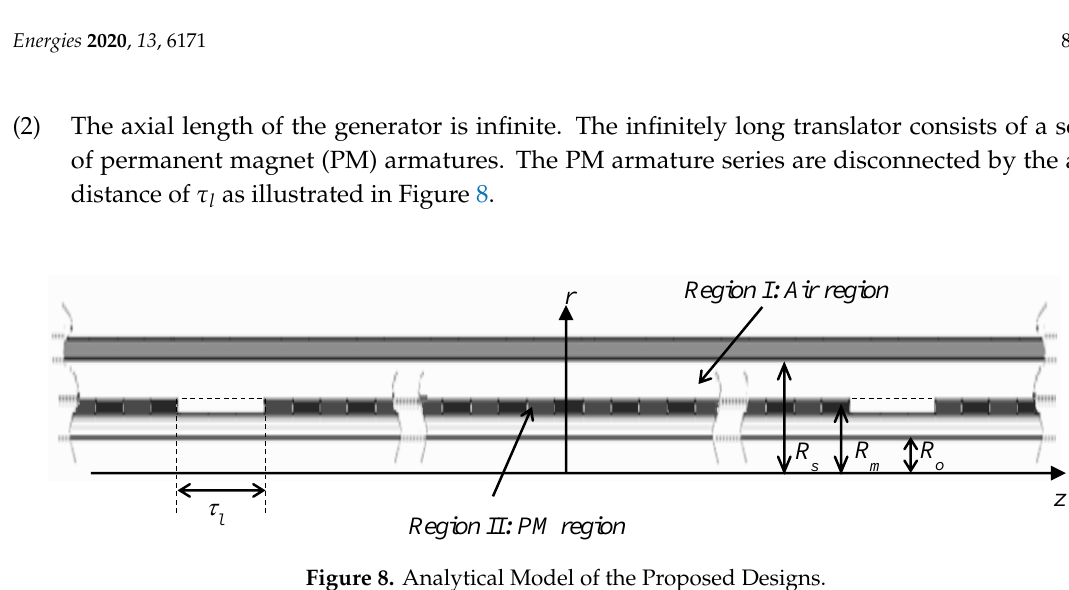
Figure 8. Analytical Model of the Proposed Designs.